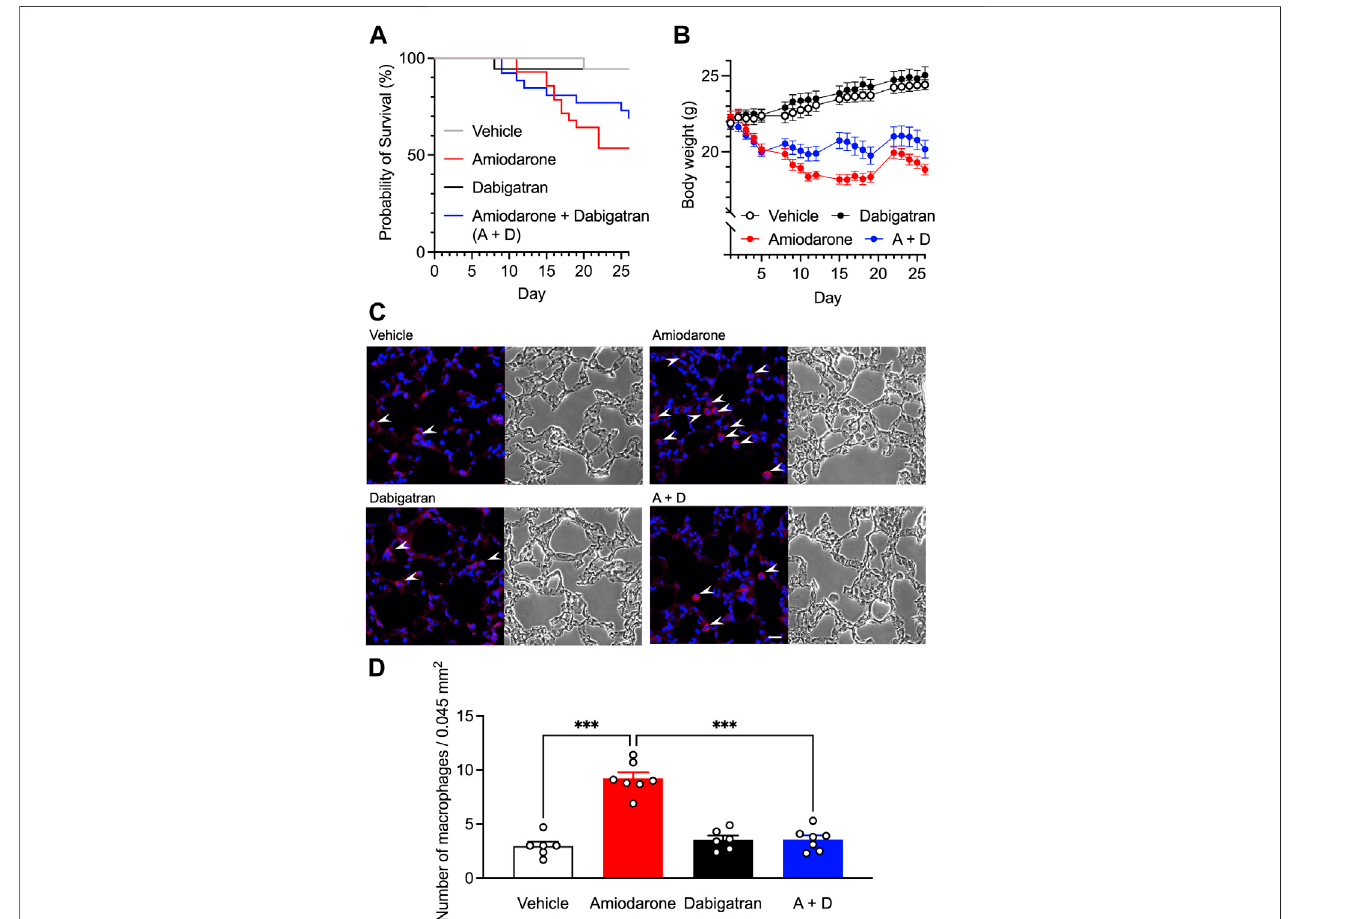
FIGURE3| Effectsofdabigatranonamiodarone-inducedlungtoxicity.Kaplan-Meiersurvivaldata (A) andthebodyweightchanges (B) ofthemaleC57BL/6Jmice orally treated with amiodarone (300 mg kg − 1 day − 1 ) and dabigatran (60 mg kg − 1 day − 1 ) or both (A + D) 5 times per week on weekdays for 4 weeks ( n (cid:1) 18 – 28 per group). Body weight data are shown as the mean ± SEM of those survived 26 days ( n (cid:1) 15 – 18 per group). Statistical signi fi cance was tested by two-way ANOVA with multiple comparisons. (C) , Representative images of Iba1-immunostaining (left) and bright fi eld (right) of mouse lung section on day 26 after chronic oral treatment withamiodarone anddabigatranorboth.White arrowheadsindicate alveolar macrophage in fi ltration. Scalebar (cid:1) 20 μ m. (D) , NumbersofIba1-positivemacrophages in the immunostained images ( n (cid:1) 6 – 7 per group). Statistical signi fi cance was tested by two-way ANOVA with Tukey ’ s multiple comparisons.